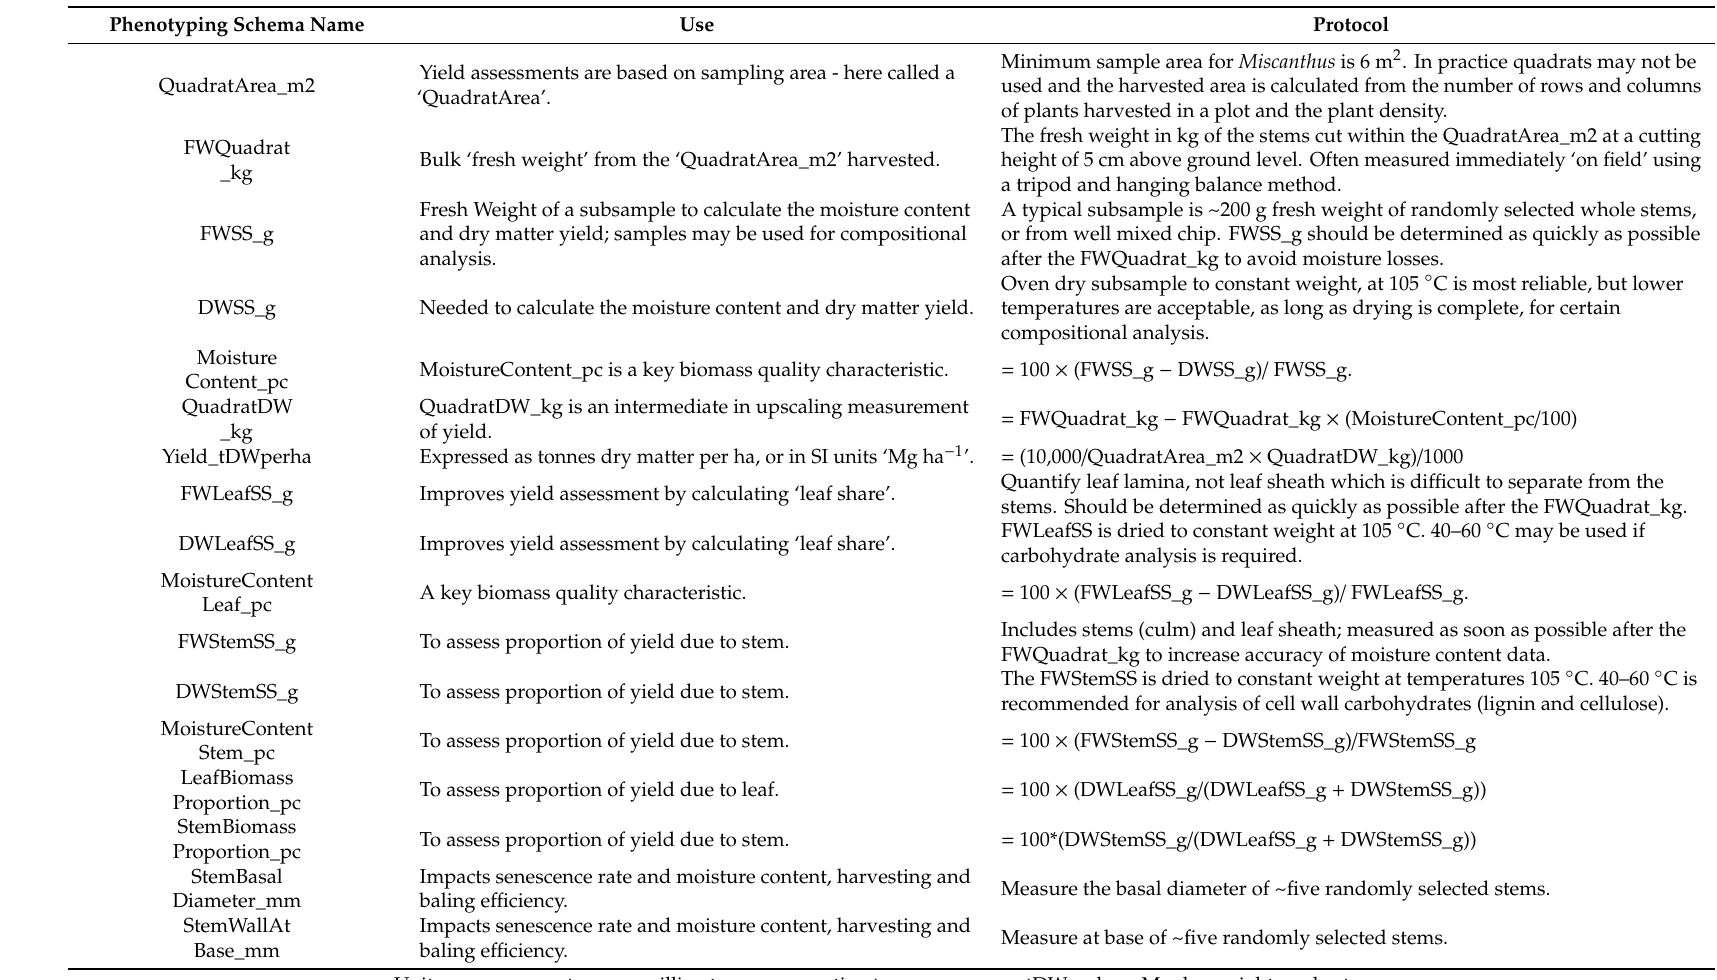
Table 2. Schemas for parameters used to quantify dry matter yield at harvest from